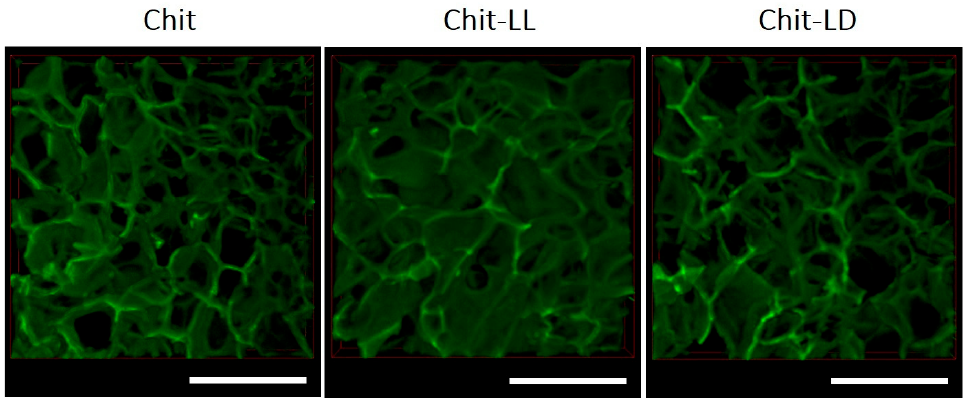
Figure 1. CLSM images of the 3D macroporous hydrogel samples produced from chitosan (Chit) and two copolymers: chitosan-g-oligo(L,L-lactide) (Chit-LL) and chitosan-g-oligo(L,D-lactide) (Chit-LD). The scale bar is 500 μ m.